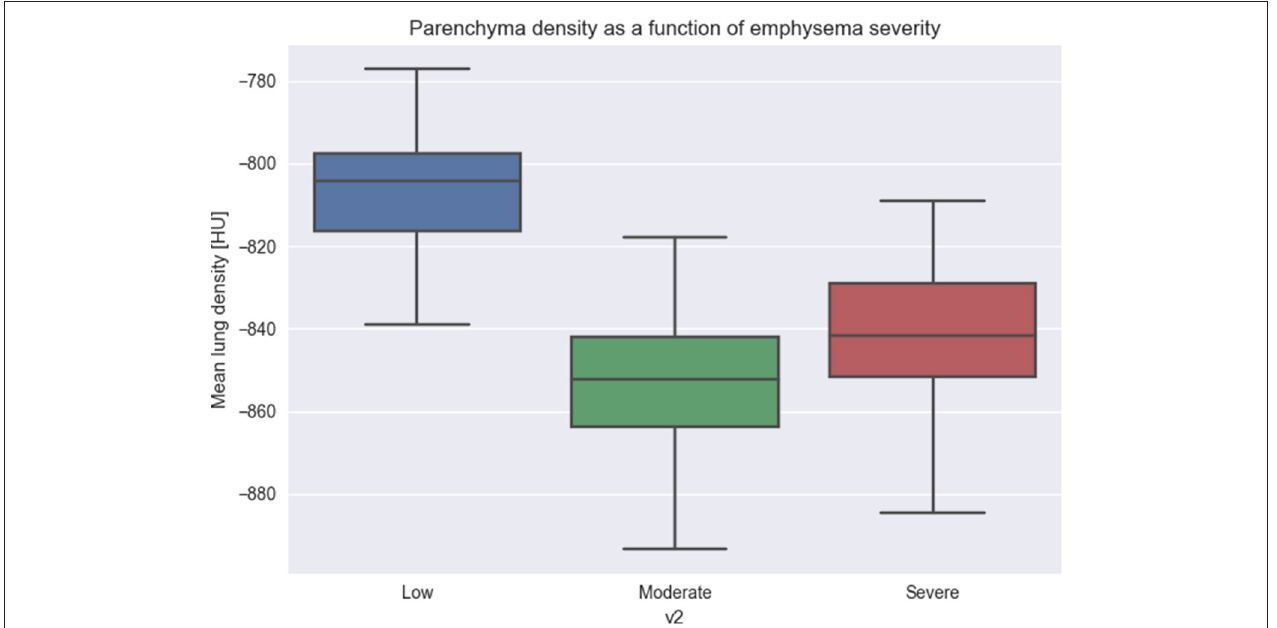
FIGURE 7 | Relation between Mean Lung Density and emphysema progression. We used Mean Lung Density (MLD) to quantify patches belonging to the three emphysema classification levels. The figure shows that emphysema progression is associated with a mean lowering of the MLD values, due to the destruction of parenchyma and the diminishing of the CT attenuation